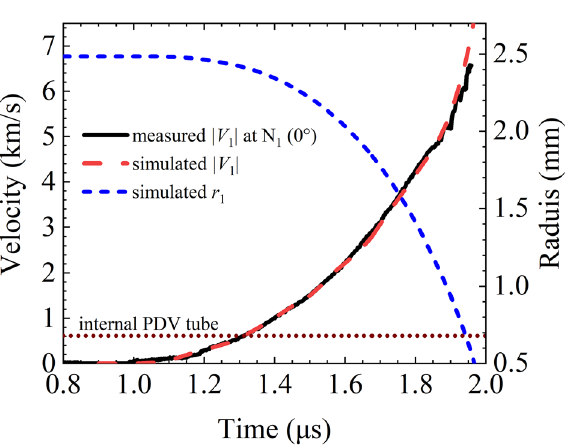
Figure 12. | V 1 | and r 1 simulated with SSS-MHD. The solid black line is the measured | V 1 | curve at N 1 (0°).